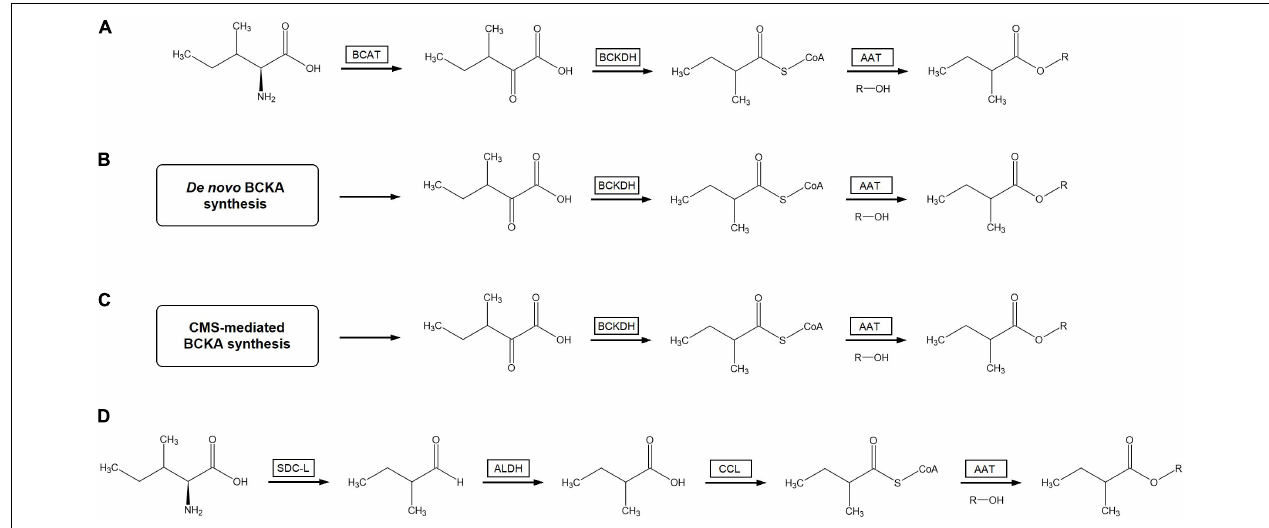
FIGURE 3 | Possible biosynthesis routes to volatile branched-chain acyl esters. (A) Mitochondrial BCAT- and BCKDH-mediated catabolism of free branched-chain amino acids to branched-chain acyl-CoAs followed by esterification with alcohols by AAT enzymes. (B) De novo chloroplast synthesis of branched-chain α -ketoacids followed by BCKDH-mediated catabolism to branched-chain acyl-CoAs and subsequent AAT-mediated esterification with alcohols. (C) CMS-initiated synthesis of α -keto- β -methylpentanoate followed by BCKDH-mediated catabolism to 2-methylbutyl acyl-CoA and subsequent AAT-mediated esterification with alcohols to form 2-methylbutanoate esters. (D) Branched-chain aldehyde synthesis from free branched-chain amino acids via SDC-L, followed by conversion of branched-chain aldehydes to branched-chain carboxylic acids through ALDH enzymes, followed by activation to branched-chain acyl-CoAs by CCL enzymes and subsequent condensation with alcohols via AAT to generate branched-chain acyl esters. The first, second, and fourth routes are capable of generating acyl esters with all three branched-chain structures, while the third route can only generate 2-methylbutanoate esters. The four pathways are illustrated yielding 2-methylbutanoate esters from appropriate precursors for ease of comparison. BCAT, branched-chain amino acid aminotransferase; BCKDH, branched-chain α -ketoacid dehydrogenase complex; AAT, alcohol acyltransferase; BCKA, branched-chain α -ketoacids; SDC-L, serine-decarboxylase like enzyme; ALDH, aldehyde dehydrogenase; CCL, carboxyl-CoA